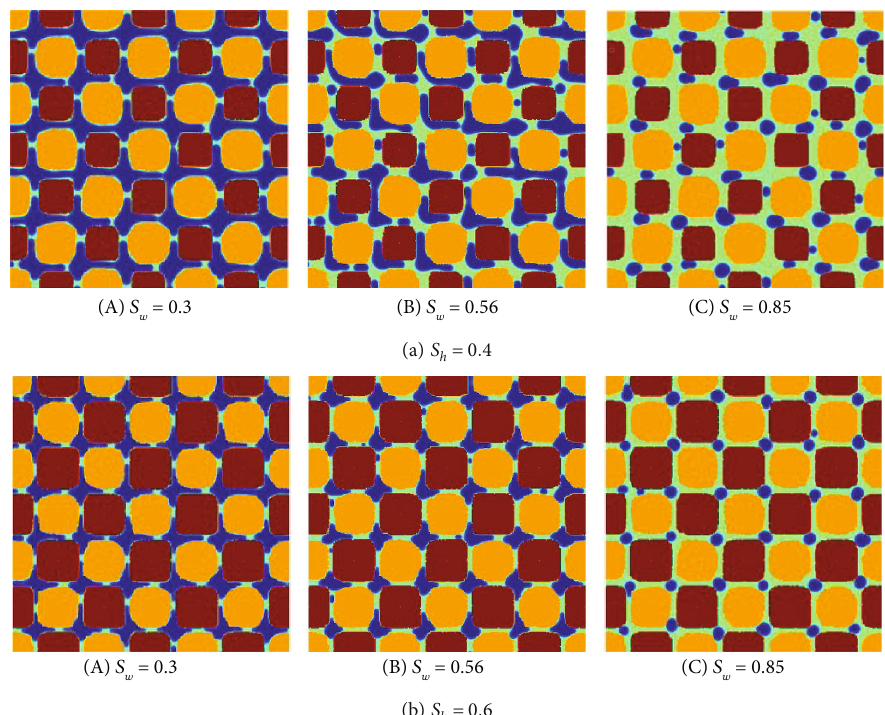
Figure 10: Gas and water dual-phase distribution patterns at S blue, water as light green, solid particles as orange, and hydrate as